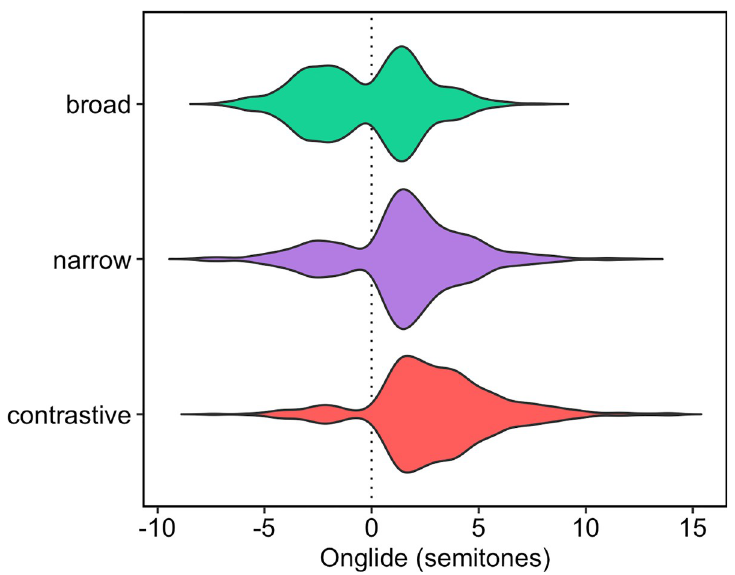
Fig 9. Distributions of raw onglide values pooled across all speakers in semitones. Negative values indicate falling accents, positive values indicate rising accents.